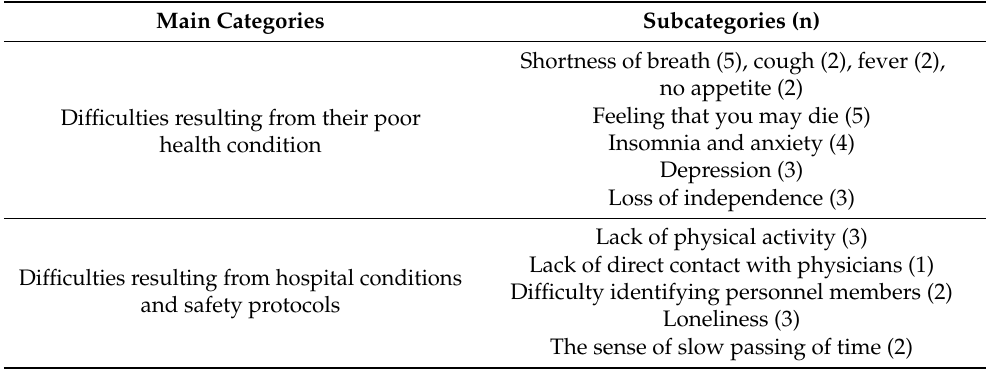
Table 2. Patients’ expressions of their most difficult experiences during hospitalization for COVID-19. Main